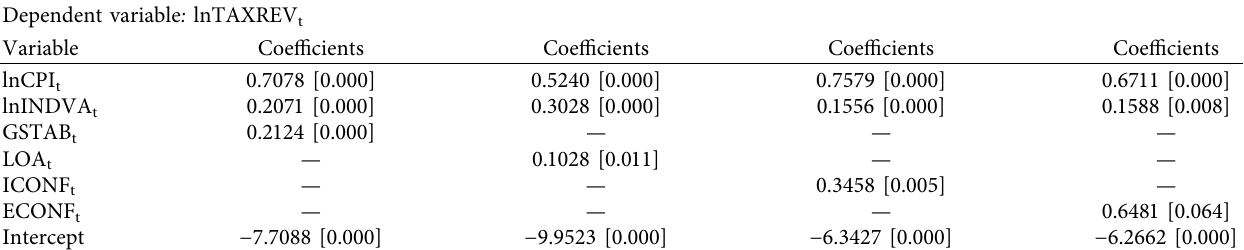
Table 6: Long-run coefficients for the selected ARDL model.